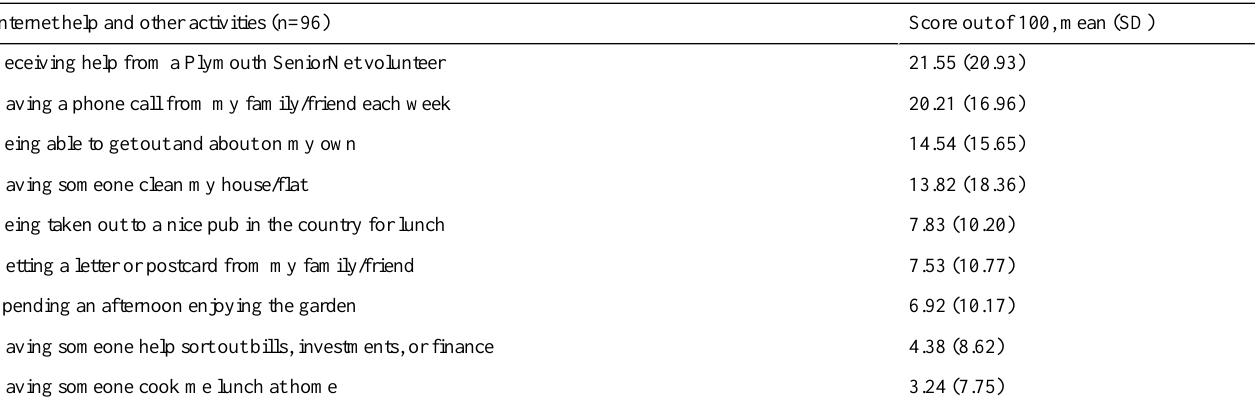
Table 6. Help using the Internet compared to other activities based on answers to question 3 from the Value of Participation postal survey: How much are the following activities worth to you?